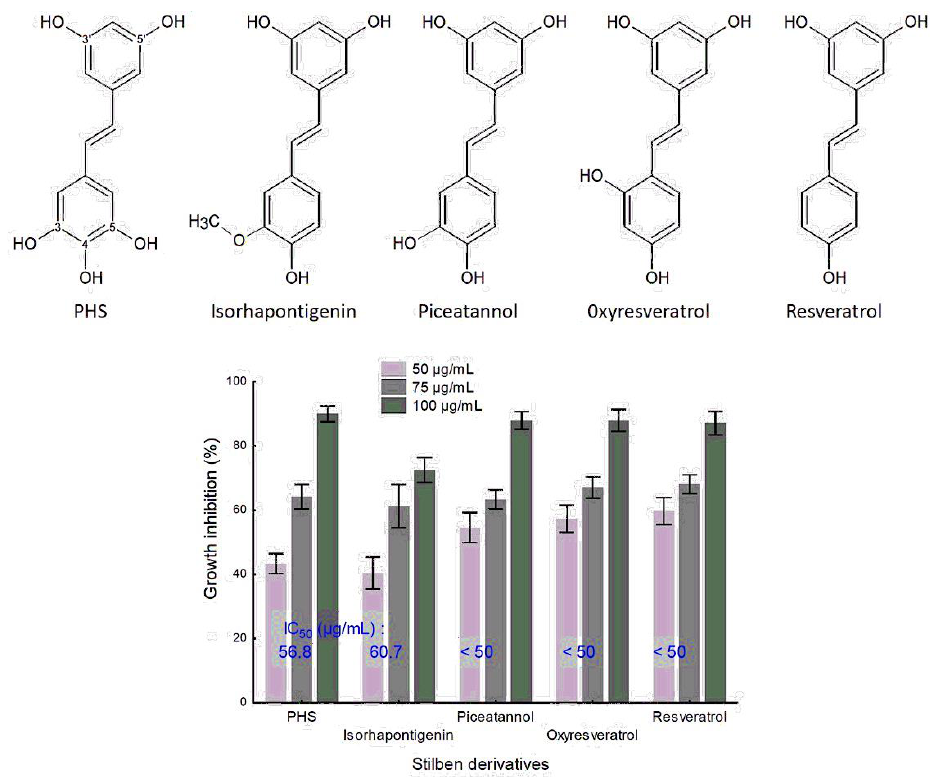
Figure 4. Inhibitory effect of five pure stilbenoids on FoA mycelium growth. Determination of the effects of piceatannol, oxyresveratrol, resveratrol, isorhapontigenin, and 3,3′,4,5,5′ -pentahydroxy- trans-stilbene (PHS) on the growth of three strains of FoA. The data are presented as mean (SD) values for each experimental condition (n = 3).